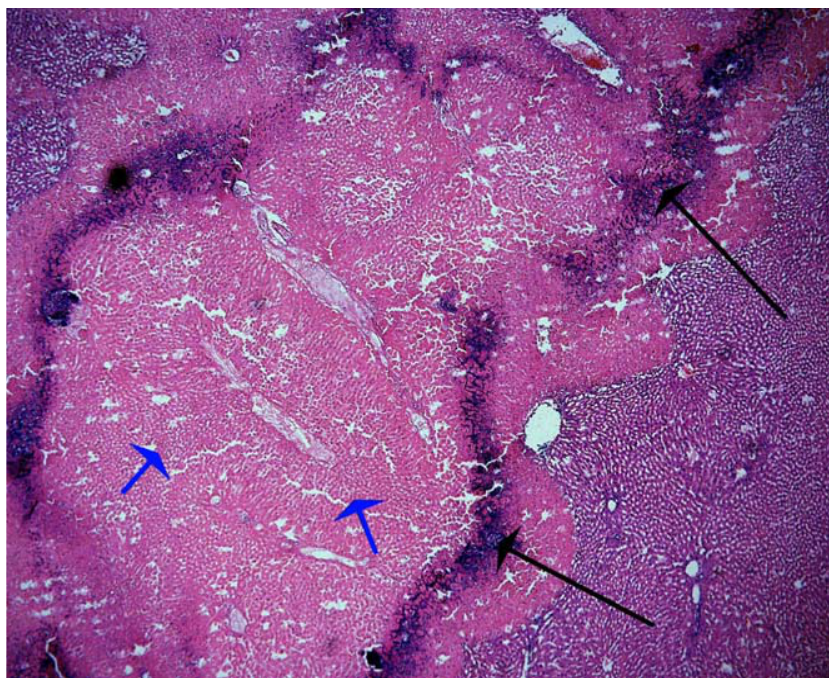
FIGURA 4 – Corte histológico do fígado de coelho decorridas 24 horas da injeção de